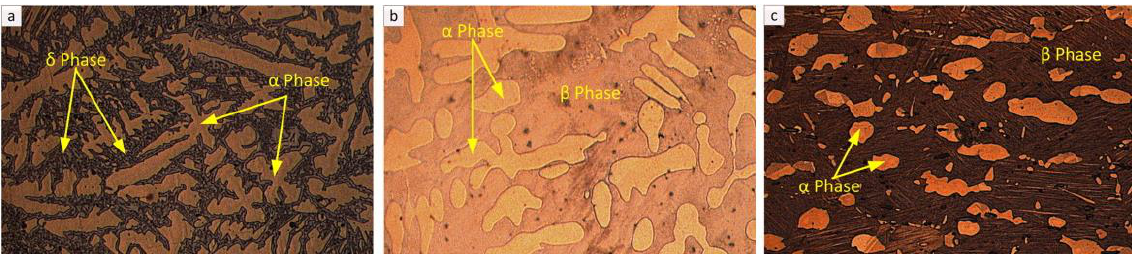
Figure 4. Optical micrograph of tin bronze (78 wt.%Cu-22 wt.%Sn). ( a ) As-cast, ( b ) quenched in oil, and ( c ) quenched in water. Reprinted with permission from Ref. [68]. Copyright 2021, Elsevier.